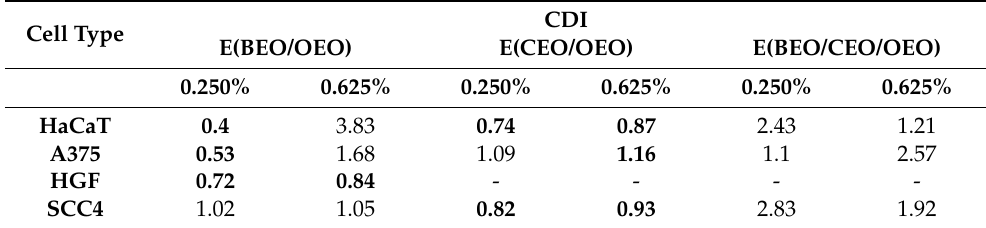
Table 2. CDI values for binary and ternary